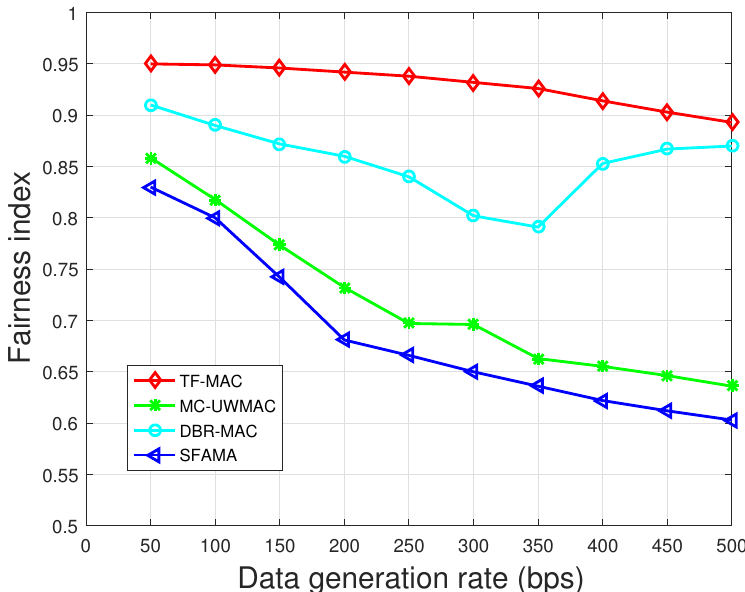
Figure 19. Comparison of the fairness index in the sparse network.